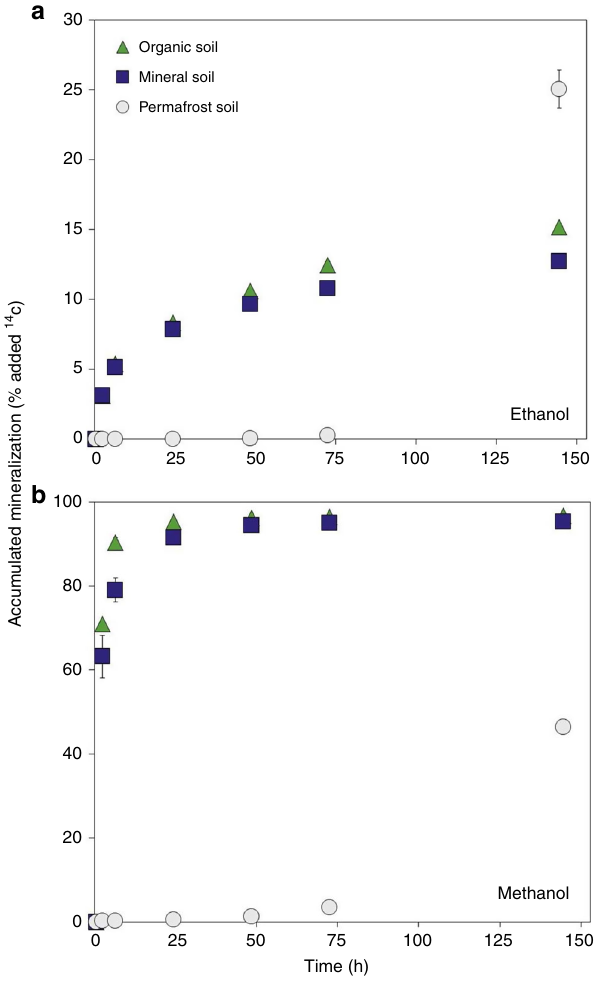
Fig. 4 Microbial mineralization of ethanol and methanol. Mean mineralization rates ( n = 3) are shown for 14 C-labeled a ethanol and b methanol in organic, mineral, and permafrost soils. Initial concentrations were approximately 3 and 1.5 µ g kg − 1 fresh weight soil for ethanol and methanol, respectively. The incubation temperature was 6 °C. Sterilized soil working as negative controls showed no mineralization. Error bars show standard error of the mean. Some error bars are smaller than the